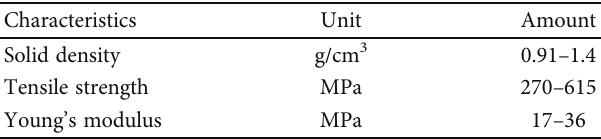
Table 2: Physical and mechanical characteristics of bamboo fi ber [28].